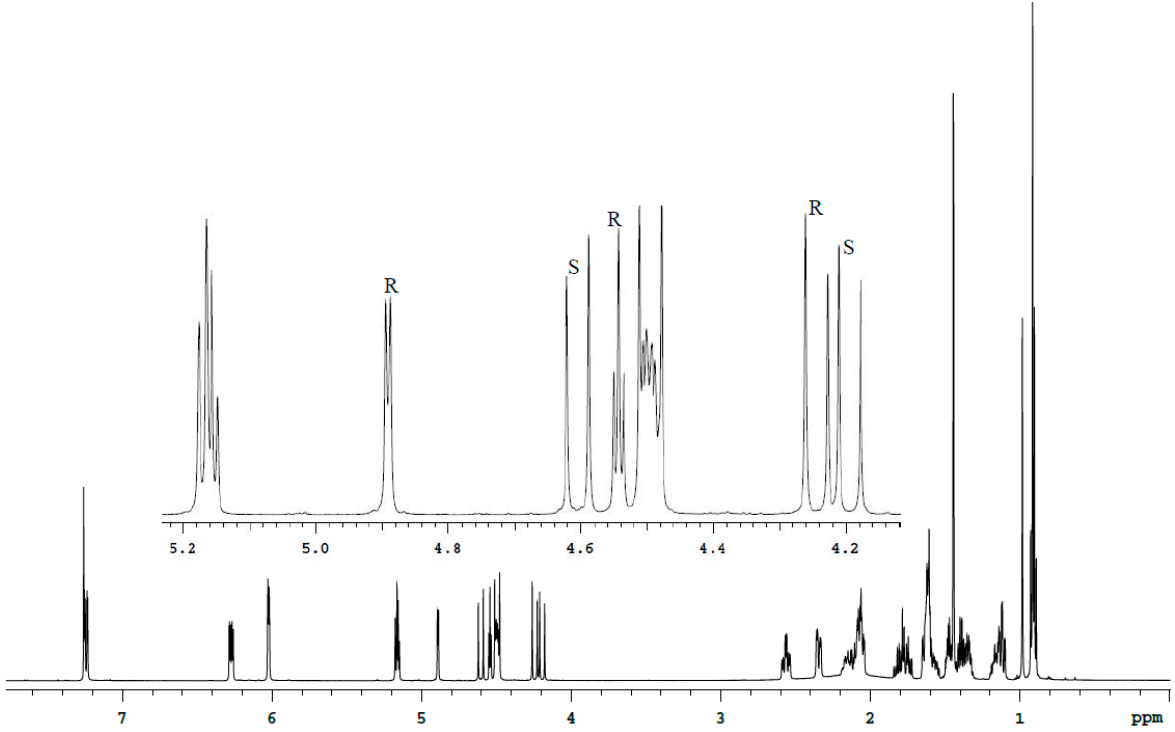
Figure 4. 1 Н spectrum of the Bud-API solution in CDCl 3 . Figure 4. 1 H spectrum of the Bud-API solution in CDCl